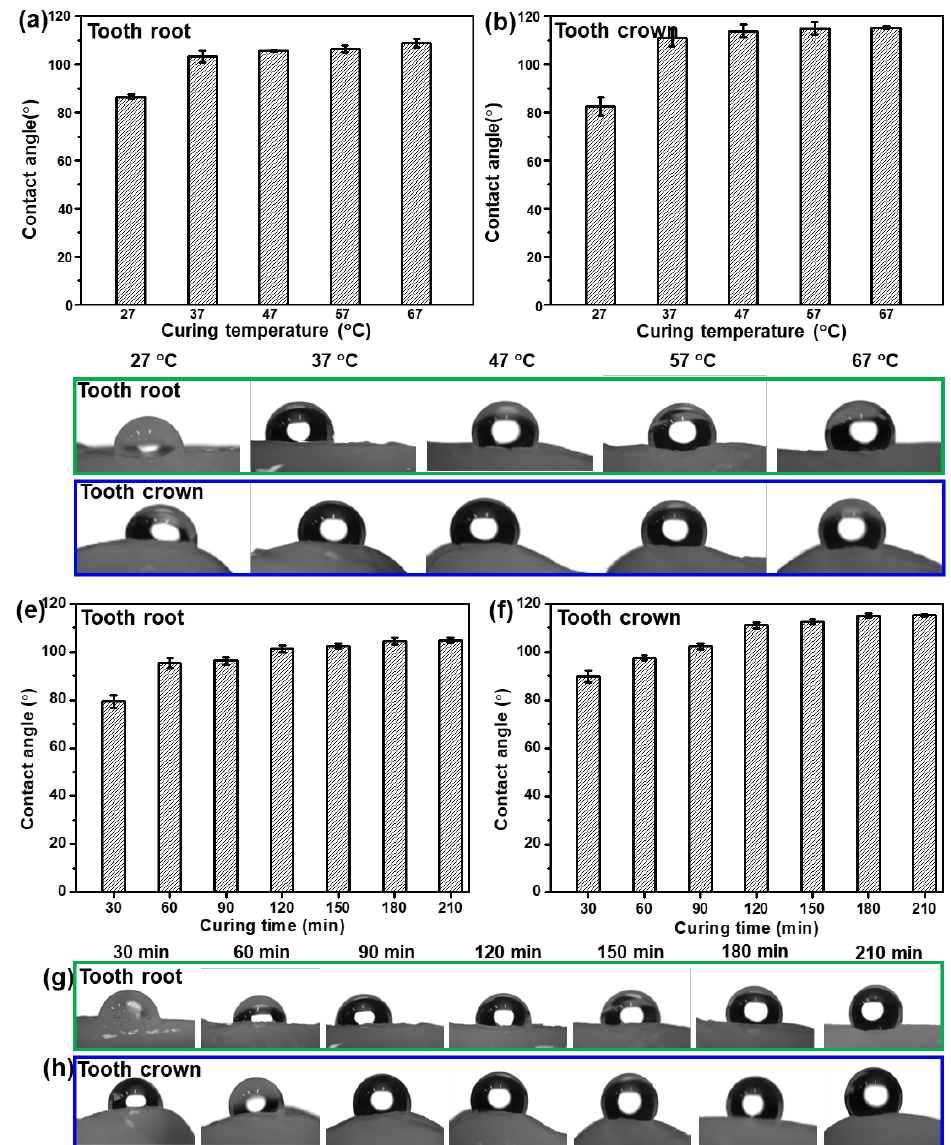
Figure 4. The influence of curing time and temperature on the hydrophobic performance of the as-fabricated Bi QDs/PDMS nanocomposites on the tooth. The θ on the ( a ) tooth root and ( b ) tooth crown as a function of curing temperature, and pictures for θ on the ( c ) tooth root and ( d ) tooth crown at different curing temperatures for 120 min. The θ on the ( e ) tooth root and ( f ) tooth crown as a function of curing time, and pictures for θ on the ( g ) tooth root and ( h ) tooth crown at different curing times at the curing temperature of 37 C.